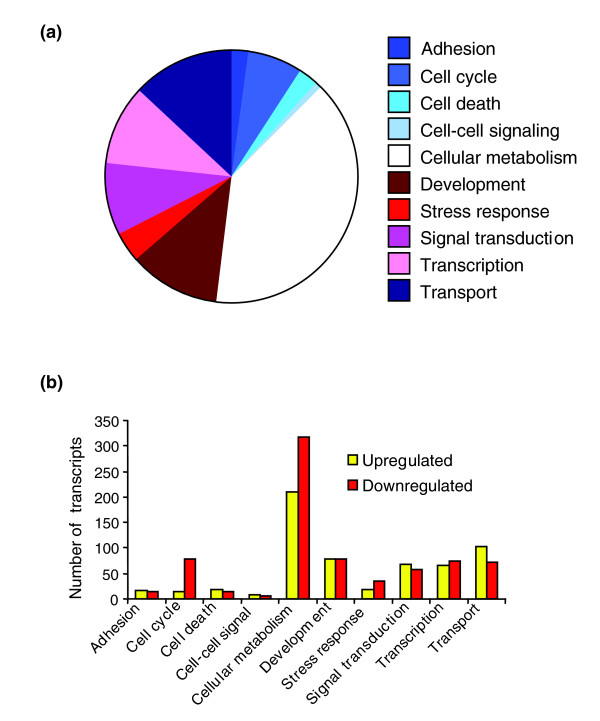
Selected GO annotations of genes differentially expressed in α-MHC+ cells. Shown are selected Gene Ontology (GO) annotations (biologic process [BP]) of genes that are differentially expressed in α-MHC+ cells as compared with the 15-day-old embryoid bodies (EBs) and compared with the α-MHC embryonic stem (ES) cells. A total of 1,845 probe set IDs, which were differentially expressed in α-MHC+ cells, were converted to Genbank accessions and redundancies were removed. SOURCE was used to obtain GO BP annotations. Genesis was used to visualize and identify GO BP categories of interest and extract corresponding lists of transcripts. (a) The pie chart shows the distribution of these annotations. (b) The bar chart shows the number of genes in the categories adhesion, cell cycle, cell death, cell-cell signalling, cellular metabolism, development, stress response, signal transduction, transcription, and transport separately for upregulated and downregulated transcripts.